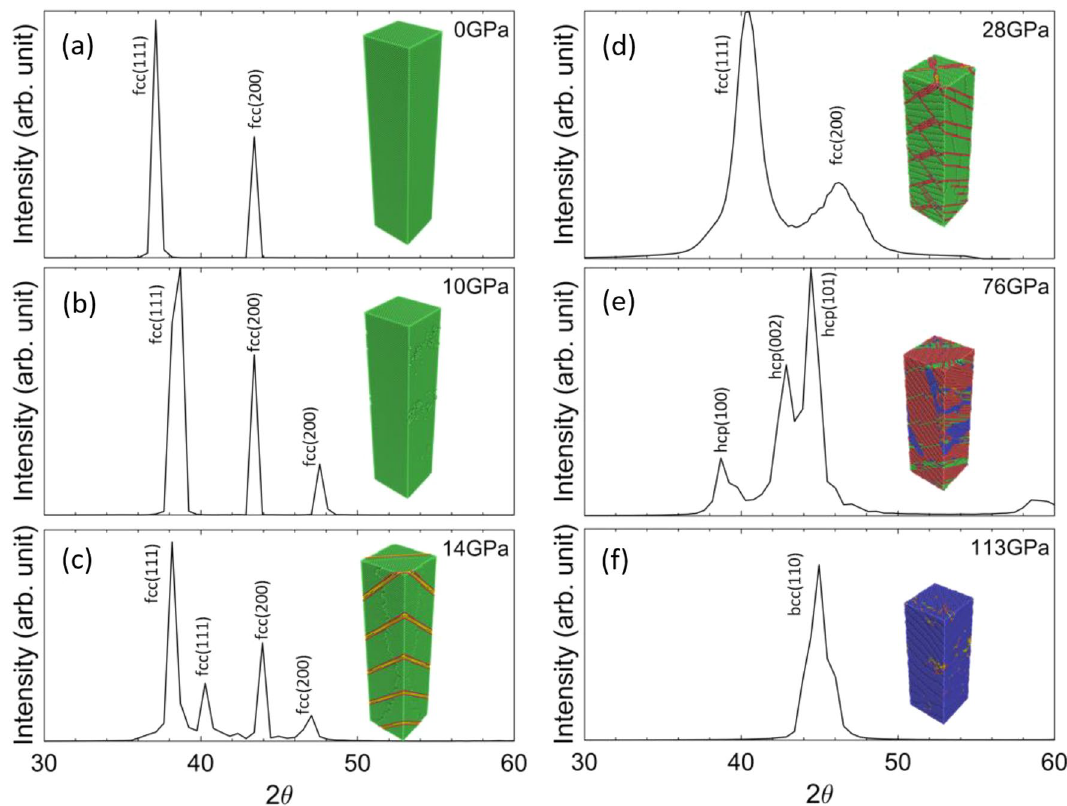
Figure 3. X-ray diffraction patterns for a representative slice (atomistic snapshots shown as insets and colored in the same manner as Fig. 2) from SC NEMD at different stress